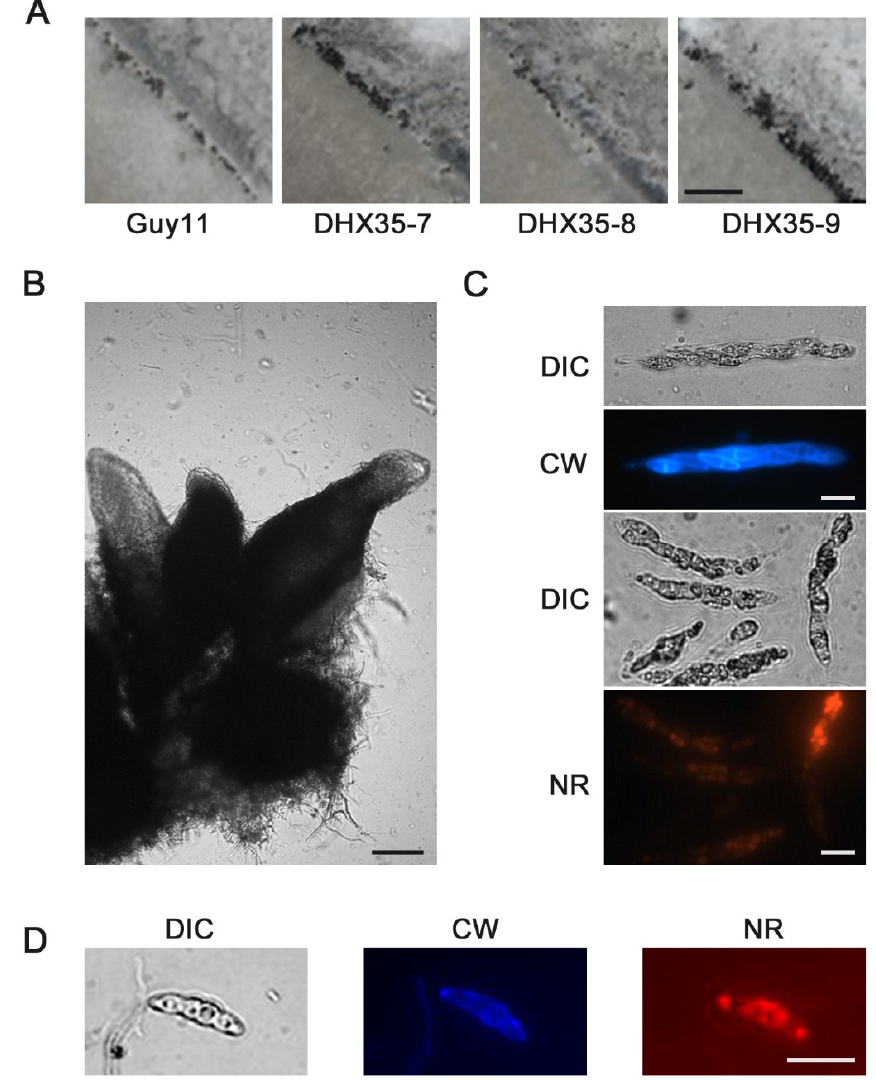
Figure 8. Sexual development of MoDHX35 mutants is normal. ( A ) The wild type and mutant were cross cultured with 2539 strains on OMA medium for 30 d. The black dotted perithecia was found on the junction zones of the strains. The bar = 1 mm. ( B ) Three typical perithecia. The perithecia have a spherical body with a long tubular beak. The bar = 50 µ m. The cell wall of ascus ( C ) and ascospore ( D ) were stained with 0.1% Calcofluor white (CW) into blue fluorescence and the lipids inside the cell were stained with 0.1% Nile-red into red. The bars =10 µ m.